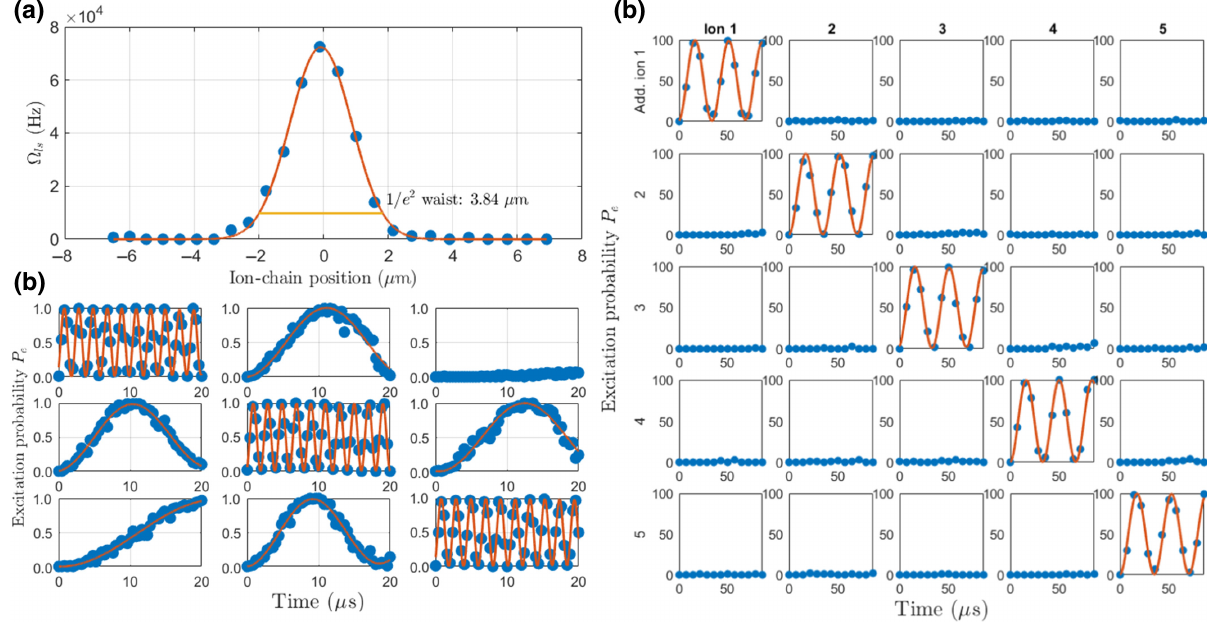
FIG. 3. (a) The beam-intensity profile of the individual addressing beam along the ion-chain axis, determined by measuring the position-dependent (cid:9) LS , which is proportional to the intensity. We measure a 1 / e 2 waist diameter of 2 w 0 = 3.84 μ m. (b) In order to characterize the individual addressing beam, we measure crosstalk on a three-ion chain. We artificially increase crosstalk by resonantly addressing the ions. The crosstalk Rabi frequency ratio is approximately 10 − 1 for a 3.7- μ m interion distance. (c) A demonstration of single-qubit Rabi oscillations using individual addressing in the light-shift configuration. Here, we use a five-ion quantum processor, with a minimal interion distance of 2.8 μ m. Each column represents one of the ve ions, in appropriate order, and each row represents an attempt to address the corresponding ion (e.g. the top row depicts the attempt to address ion 1).